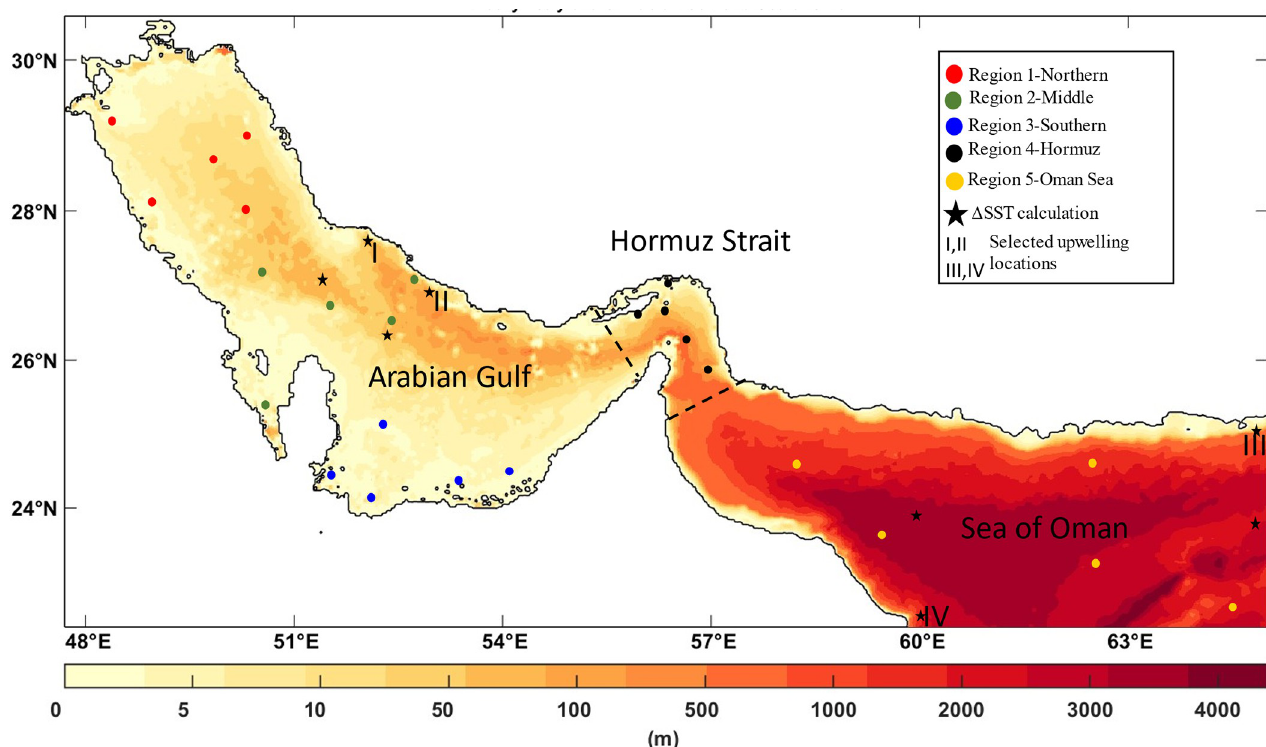
Fig 1. Bathymetry of the Arabian Gulf and the Sea of Oman map. The filled circles are locations where the inorganic nutrient’s vertical profile is plotted, red: Region 1-Northern; green: Region 2-Middle; blue: Region 3-Southern; black: Region 4-Hormuz Strait; orange: Region 5-Sea of Oman. The black stars represent places where the upwelling index is calculated using a simple thermal difference of the ocean and coastal SST: UI numbers (I, II,III,IV) are regions of upwelling where inorganic nutrients are analysed.